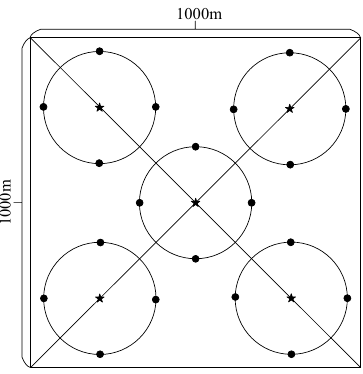
Figure 2. Plot design of LAI measurements.